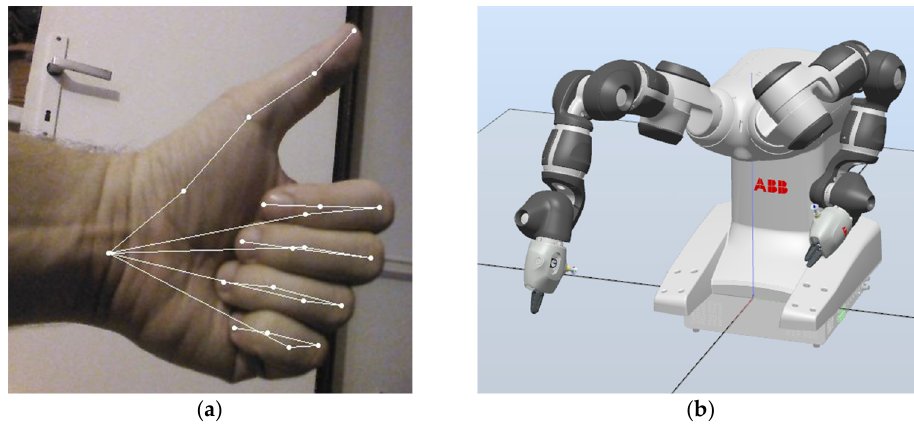
Figure 8. ( a ) Detected points on the hand with the result of 1 extended finger after data processing. ( b ) Movement of the robot arm to the appropriate position according to the number of outstretched fingers.